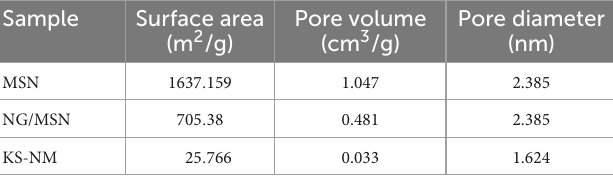
Figure 3 is the XRD diffraction pattern of NG nanoparticle gel spheres used to explore the internal crystal structure of KS